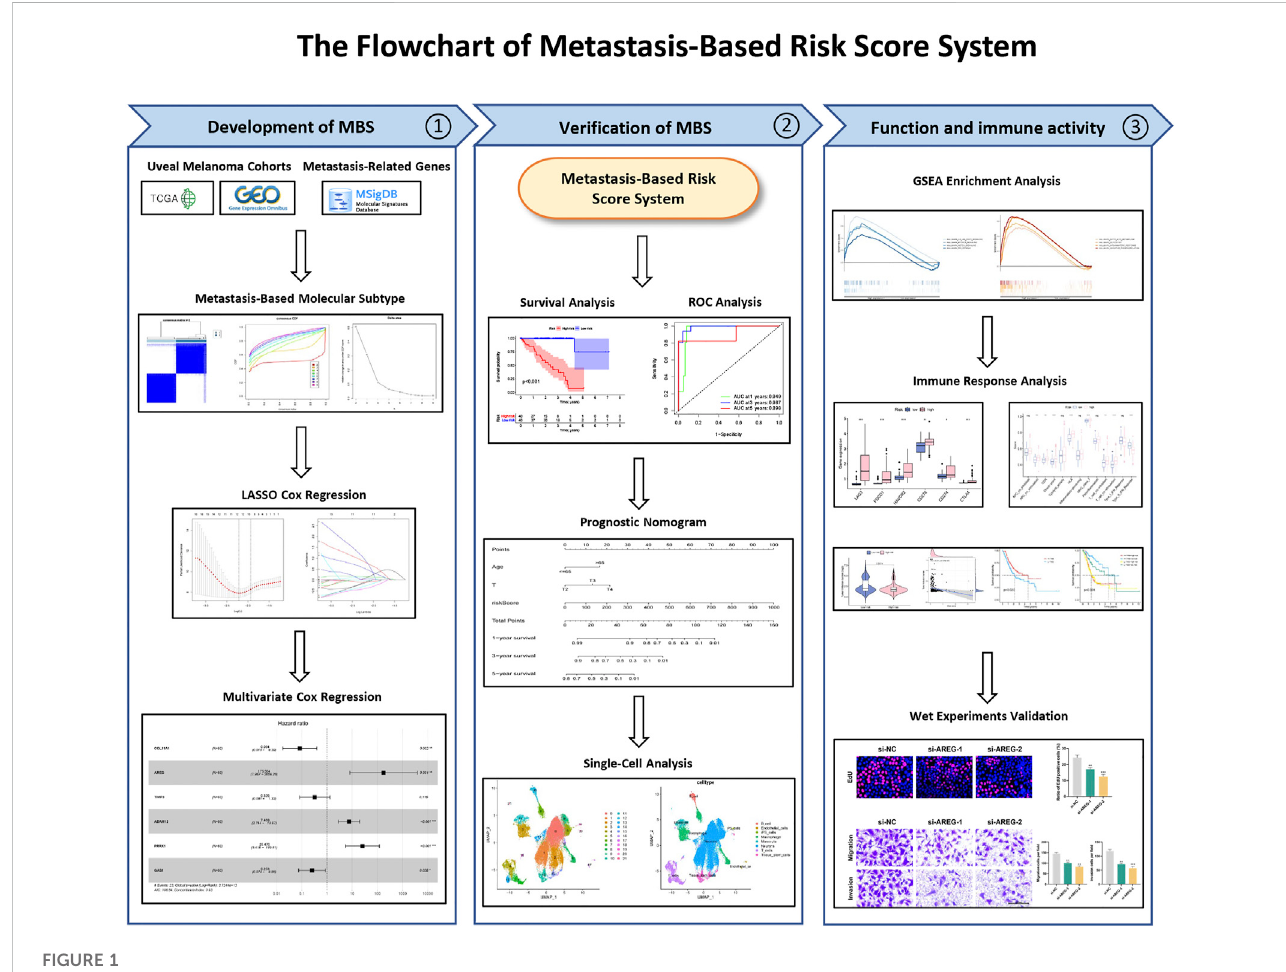
FIGURE 1 The fl owchart of the present